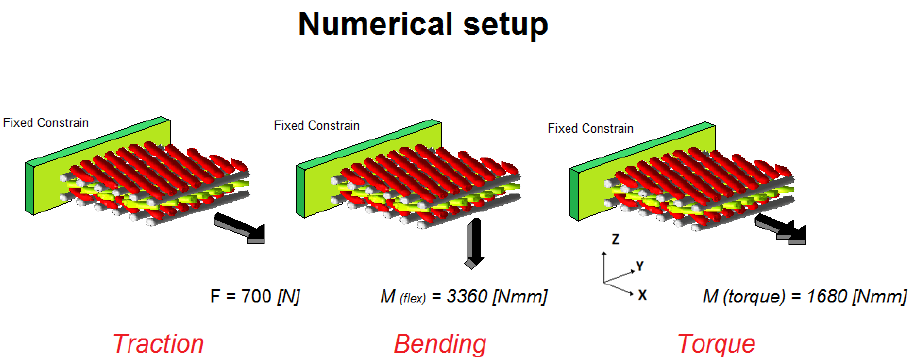
Figure 2. Boundary conditions of numerical